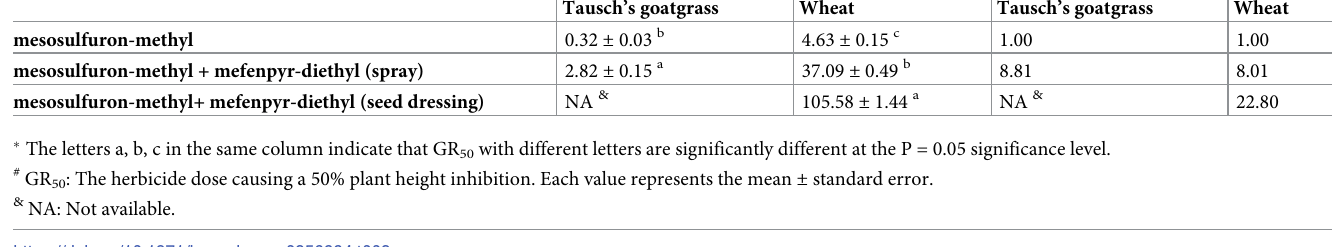
Table 2. The response of Tausch’s goatgrass and wheat to mesosulfuron-methyl and mefenpyr-diethyl � .